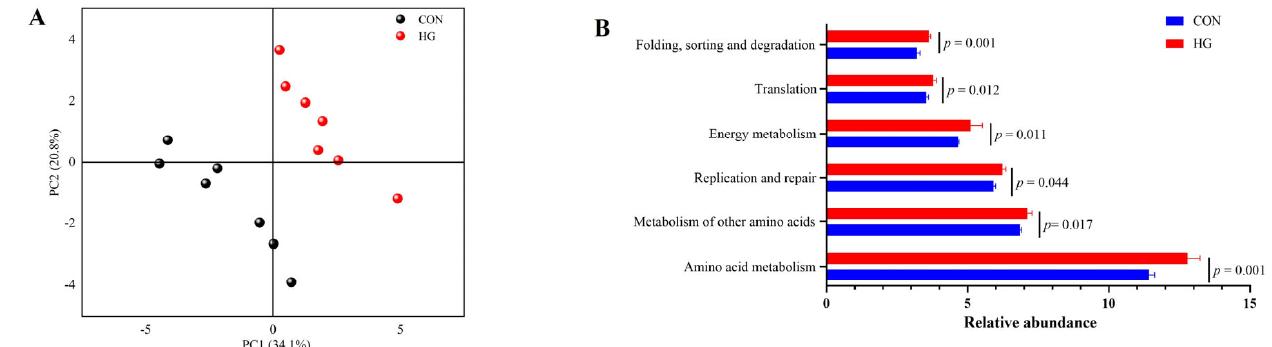
Figure 3. Functional predictions of rumen microbiota of yaks fed different diets. CON, hay group; HG, high ‐ grain group. ( A ) A principal component analysis of KEGG pathways, and ( B ) the functional predictions of rumen microbiotas with significant differences at the KEGG 2.